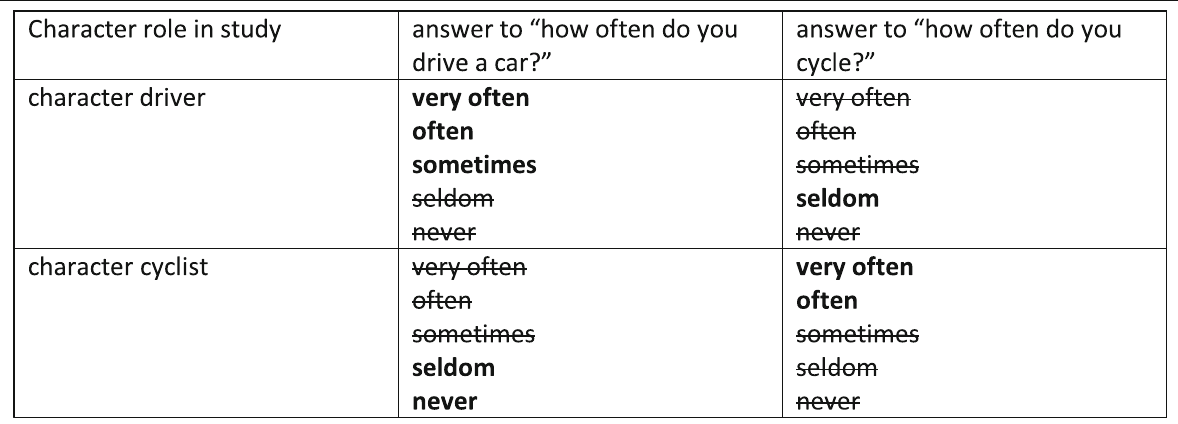
Table 2 Grouping criteria from answers on the recruitment form